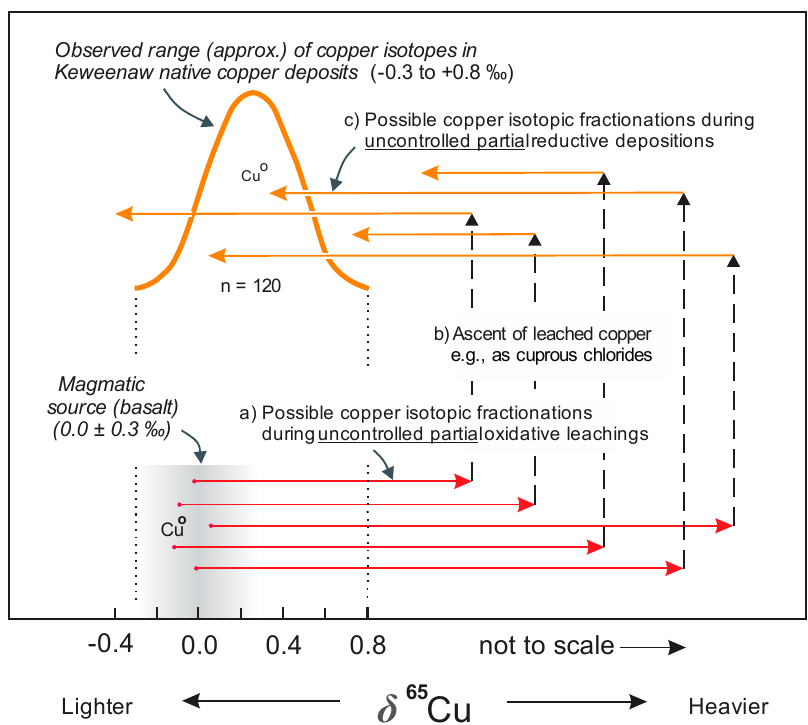
Figure 1. An interpretation of the fractionation of copper isotopes during the formation of Keweenaw native copper deposits, based on processes described in Bornhorst and Mathur [1]. First, during leaching of copper (Cu) from source basalts (assumed to have had δ 65 Cu values of 0.0 ± 0.3‰), copper isotopic fractionation accompanying oxidative leaching of copper (Cu 0 → Cu + ) would have trended toward heavy δ 65 Cu values in the metamorphogenic solution (five red arrows, representative of the potential range of δ 65 Cu values among 120 actual samples). The minimal δ 65 Cu value would have been +0.8‰, that is, the heaviest value among the 120 analyzed native copper samples. Then, those isotopically heavy solutions ascended and deposited up-dip native copper mineralization by reductive copper deposition (Cu + → Cu 0 ), accompanied by copper isotopic fractionations toward lighter δ 65 Cu values (orange arrows). The successive isotopic fractionations toward heavy and then light δ 65 Cu values would have depended on uncontrolled extents of partial copper leaching and partial copper deposition, respectively, and thus the ultimate δ 65 Cu values (heads of orange arrows) would not necessarily have fallen within the well-grouped range of observed δ 65 Cu values.